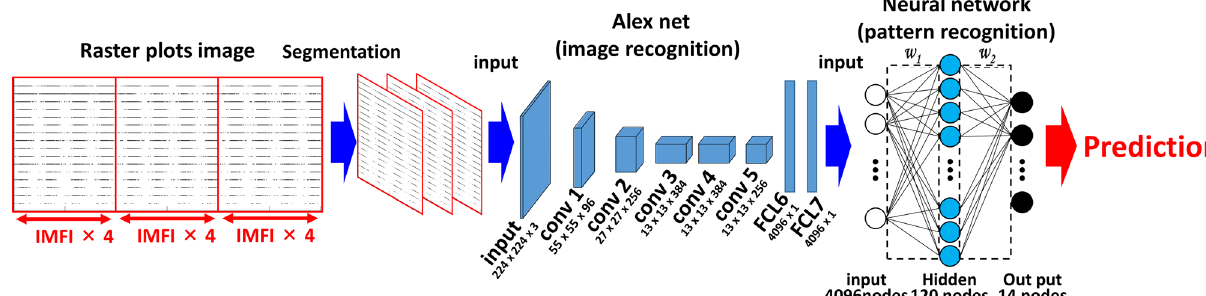
Figure 7. Creation of drug name prediction AI using raster plot images. Data flow and architecture of drug name prediction model. w1 is the weight between the input layer and the hidden layer; w2 is the weight between the hidden layer and the output